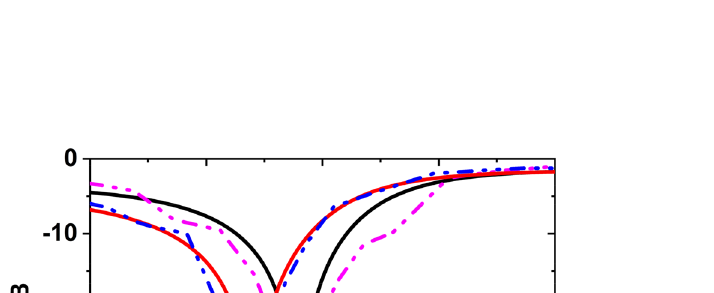
Figure 16. Measured ( a ) DK and ( b ) LT for the corn oil and olive oil.